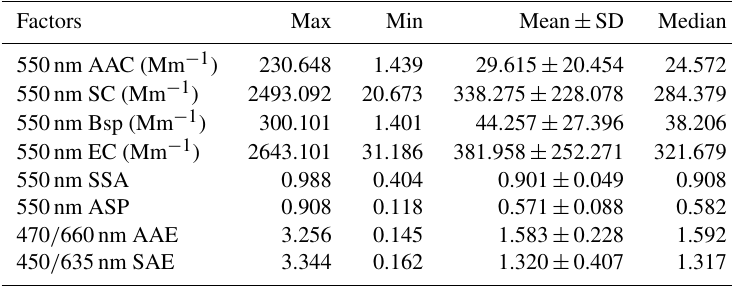
Table 1. Statistical summary of the surface aerosol optical properties in Nanjing.